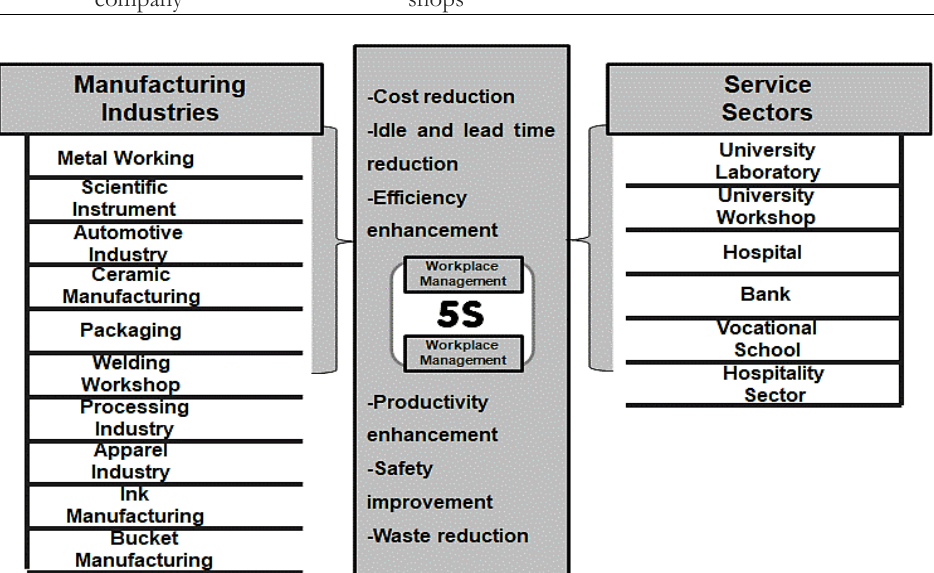
Fig. 3. Types of manufacturing industries and service sectors where 5S is implemented.